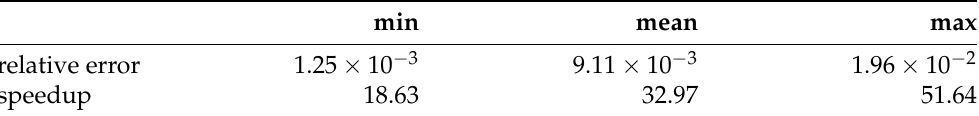
Table 4. Parameter study for the sPOD-sDEIM ROM over the Arrhenius coefficients with 81 samples from β = 540K to β =